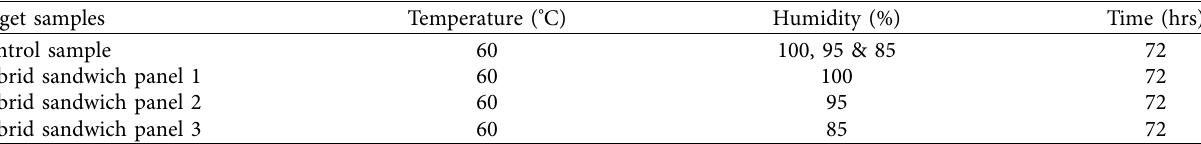
Table 2: Weathering test conditions for sandwich panels.